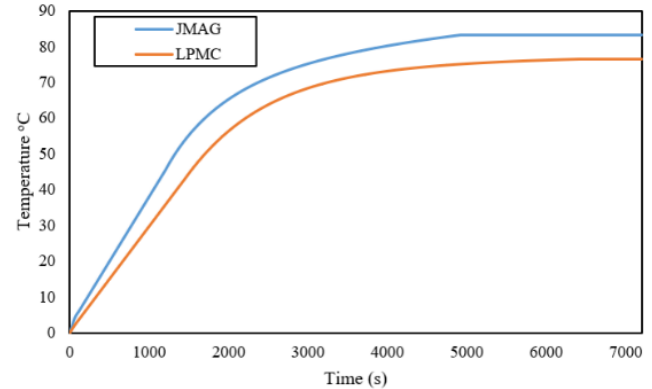
Figure 30. Overall comparison of the FEA and LPMC